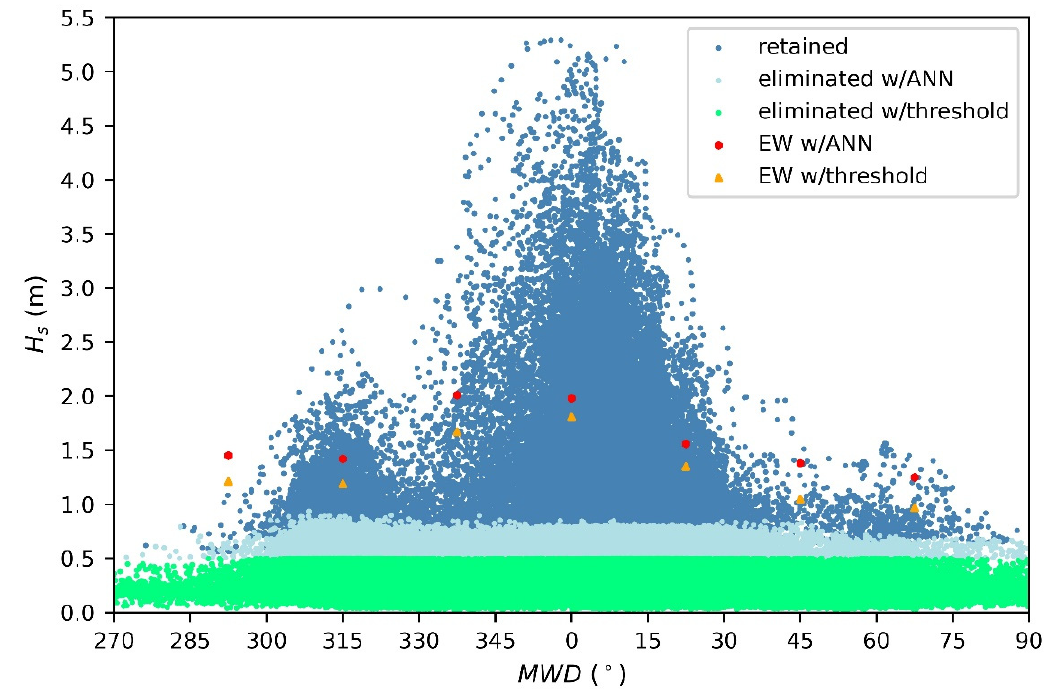
Figure 9. Retained (blue markers) and eliminated (light blue markers) sea-states by implementing the proposed methodology and by employing an arbitrary threshold (green markers). The red data points denote the representatives for the simulation “EW w/ANN” and the orange those by following the “EW w/threshold” approach.